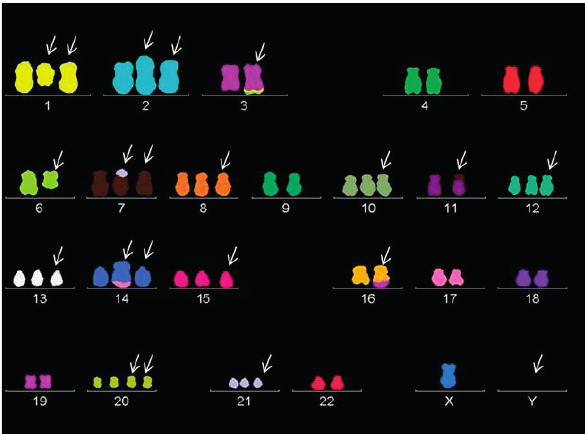
Fig. 4. Karyotype from the bone marrow